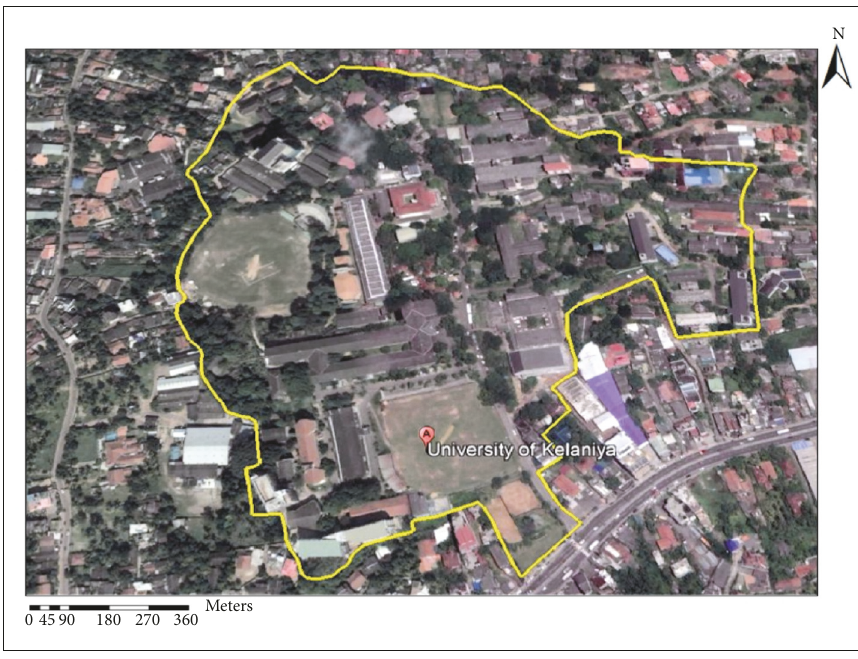
Figure 1: The study area of University of Kelaniya. Table 1: Habitat categorization depending on the nature and percentage of tree cover of the environment. Percentage of cover of the wooded Type of the habitat Habitat Number (H) Common name of the habitat vegetation (%) H 1 Saiba ground (SG) 1.7 open